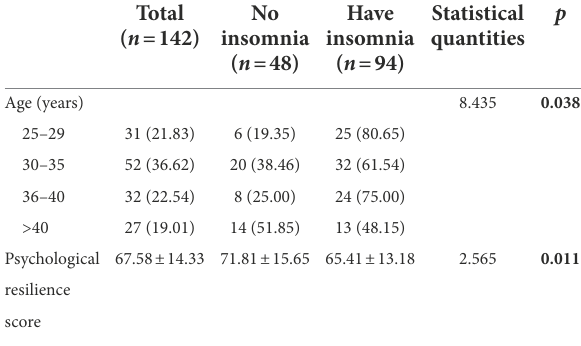
TABLE 9A Analysis of the influencing factors of ISI.